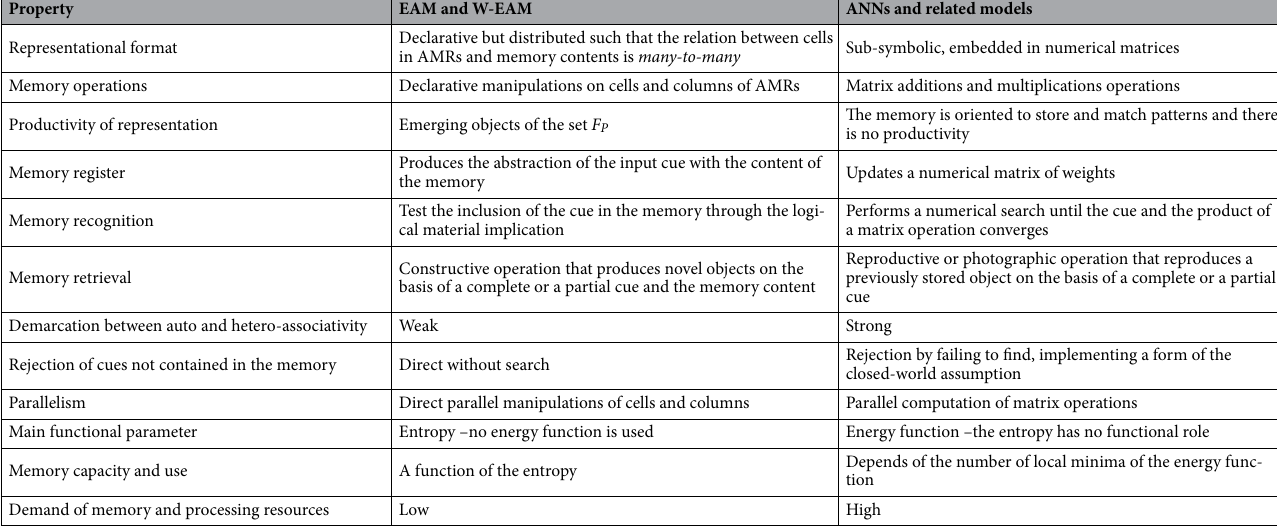
Table 1. Summary of differences between EAM and W-EAM and associative memory models developed within the Artificial Neural Networks